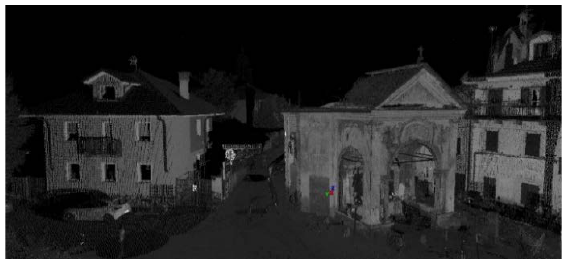
Figure 5: TLS (Leica C10 -10 scan stations) point cloud of Chapel two (architectural